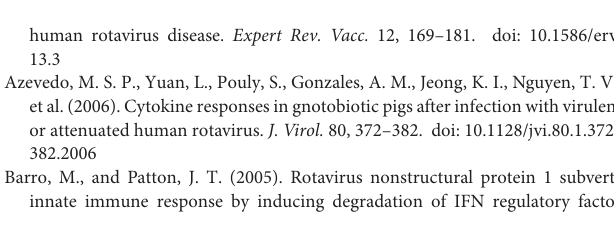
TABLE S1 | Summary of gene specific primers used for RVC detection and